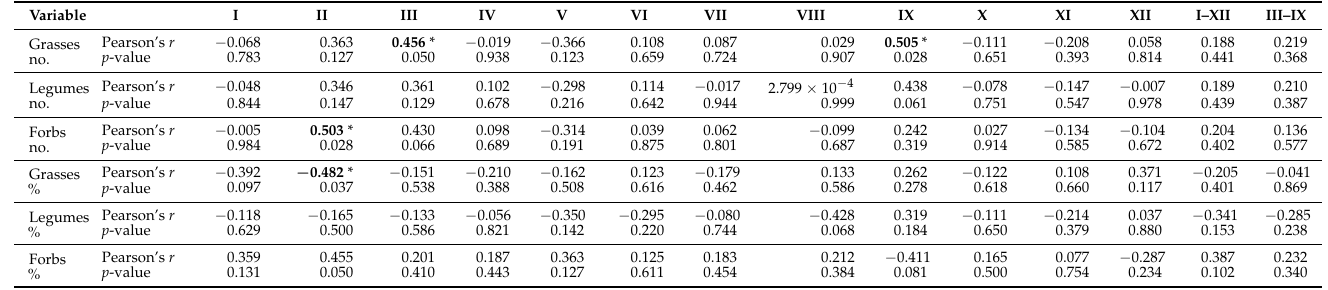
group, correlations in the timeframe of the present research were not identified. Table 3. Correlations between the averages of the temperature (I–XII) and floristic composition in ex-arable grassland from Gr ă dinari (period 2003–2021).